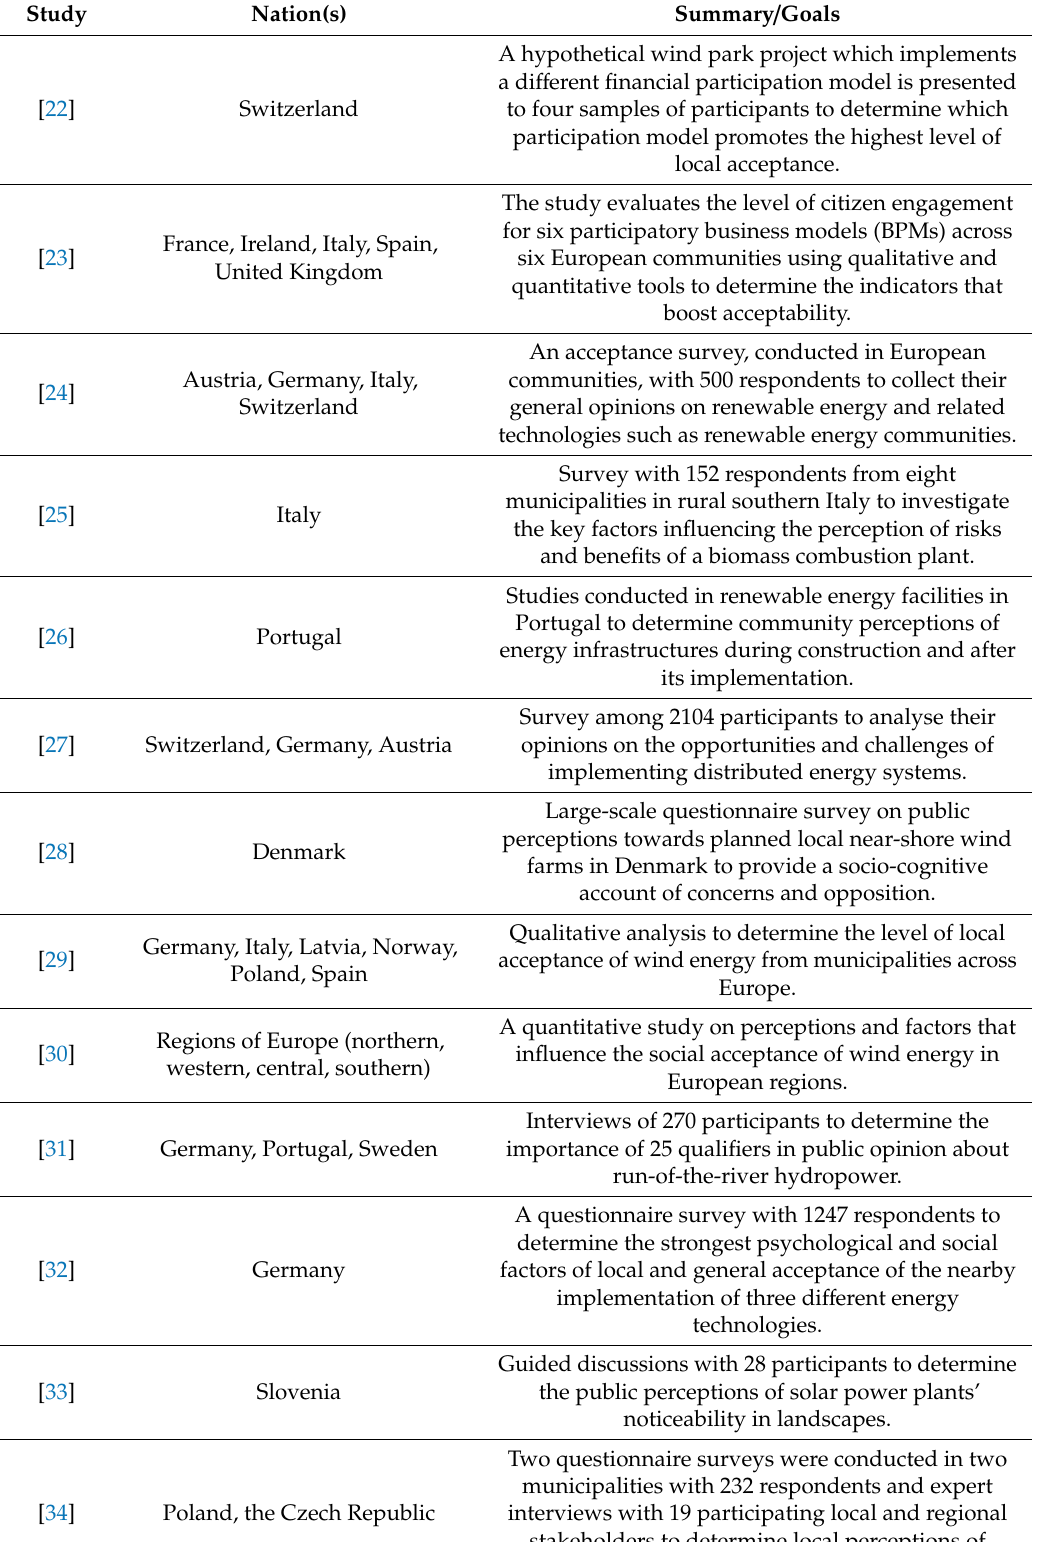
Table 1. Summary of materials used for the quality comparative